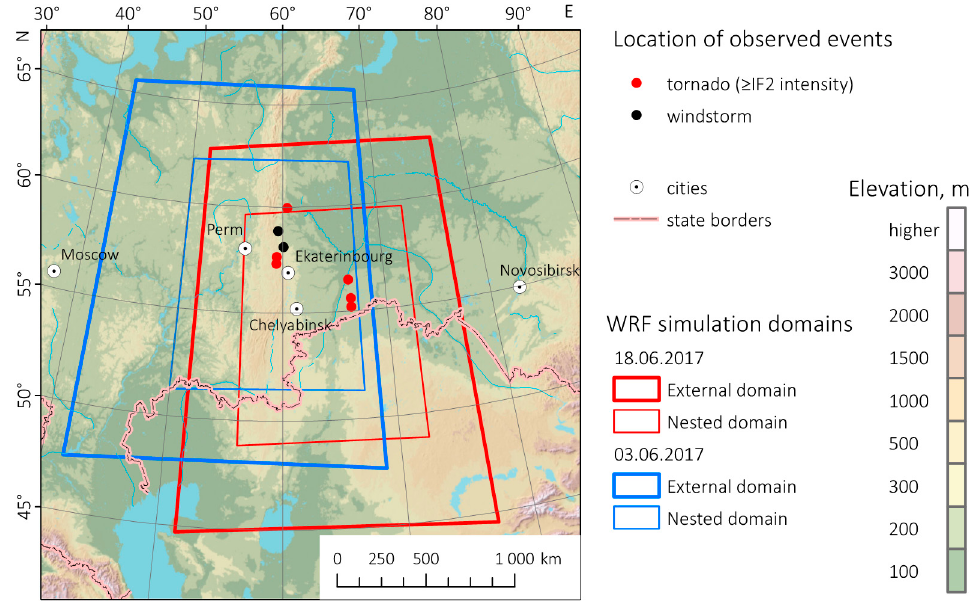
Figure 1. WRF simulation domains for the 3 June 2017 and 18 June 2017 storm events.